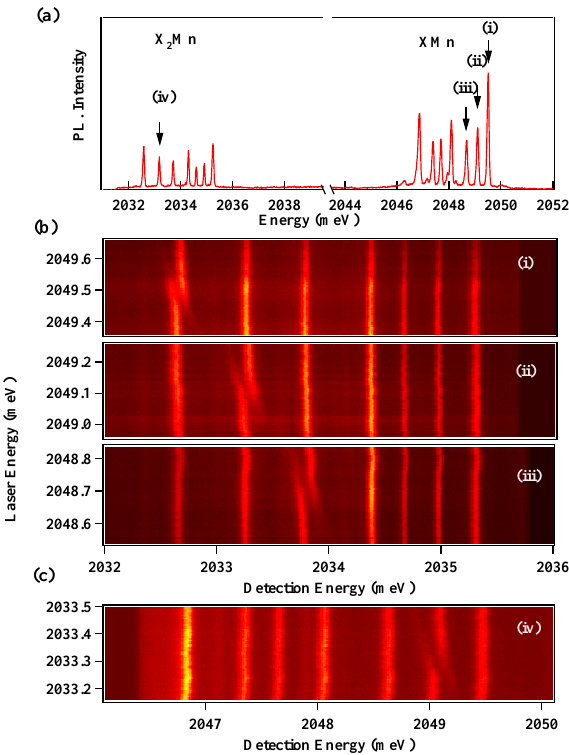
Figure 6: (a) PL of the exciton and biexciton in a Mn-doped QD. (b) Autler-Townes splitting of the exciton detected on the biexciton PL under resonant excitation of the ground-to-exciton transition for the spin state of the Mn S z = +5/2 (i), S z = +3/2 (ii) and S z = +1/2 (iii) (arrows in the PL spectra). (c) Emission of the exciton for a dressed exciton-to-biexciton transition. The excitation is tuned around the state S z = +3/2 of the biexciton (iv).